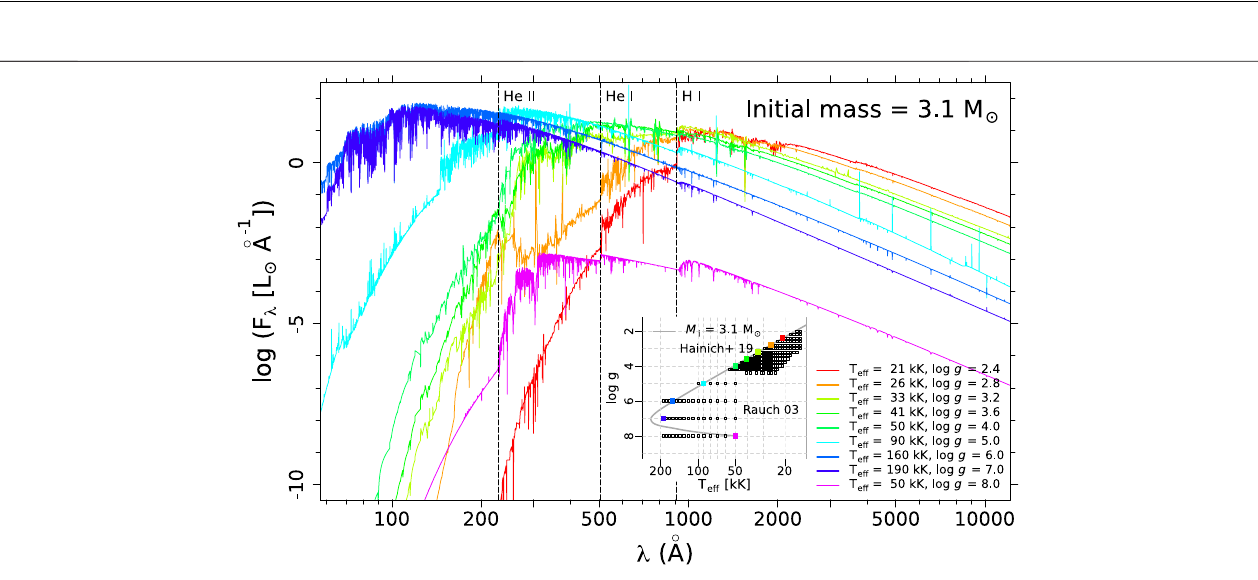
FIGURE 2 | The same as Figure 1 , but for a star with initial mass of 3.1 M ⊙ . The time elapsed between the fi rst ( red ) and the last ( purple ) phase is 1.6Myr.